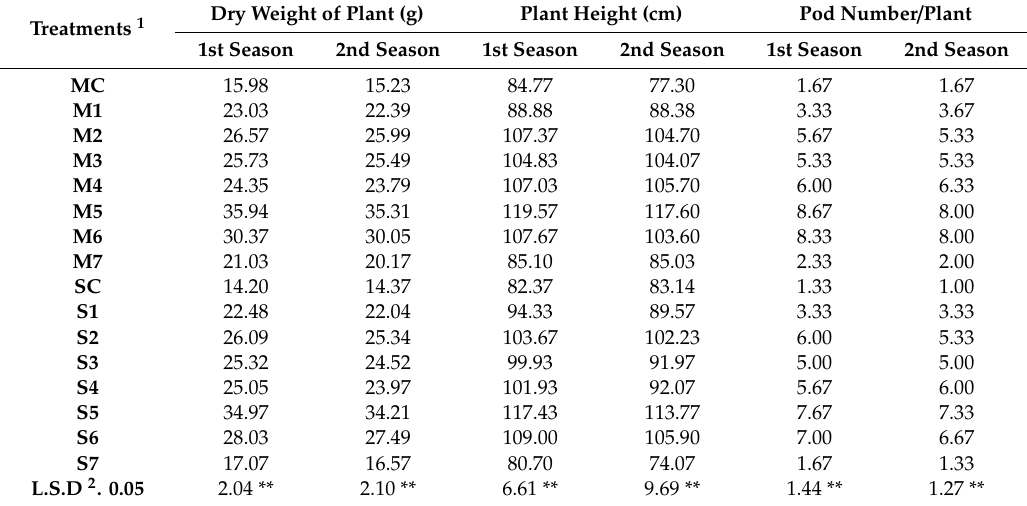
Table 7. E ff ect of spent mushroom substrate extract (SMSE), mushroom culture filtrate (MCF), and Roundup ® treatments to control broomrape infestation on plant dry weight, plant height and pod numbers of faba bean plants at harvesting stage during two